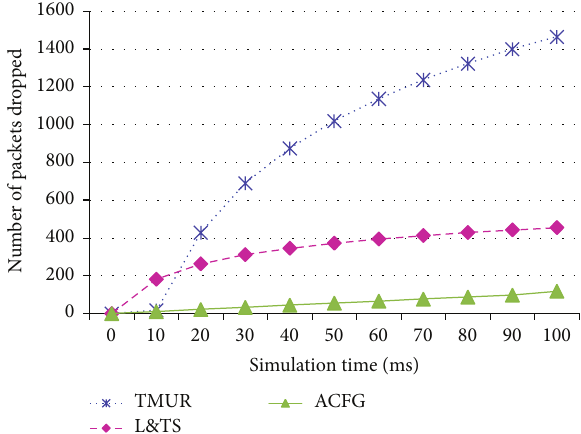
Figure 12: Packet Loss Rate of TMUR, L&TS, and ACFG.